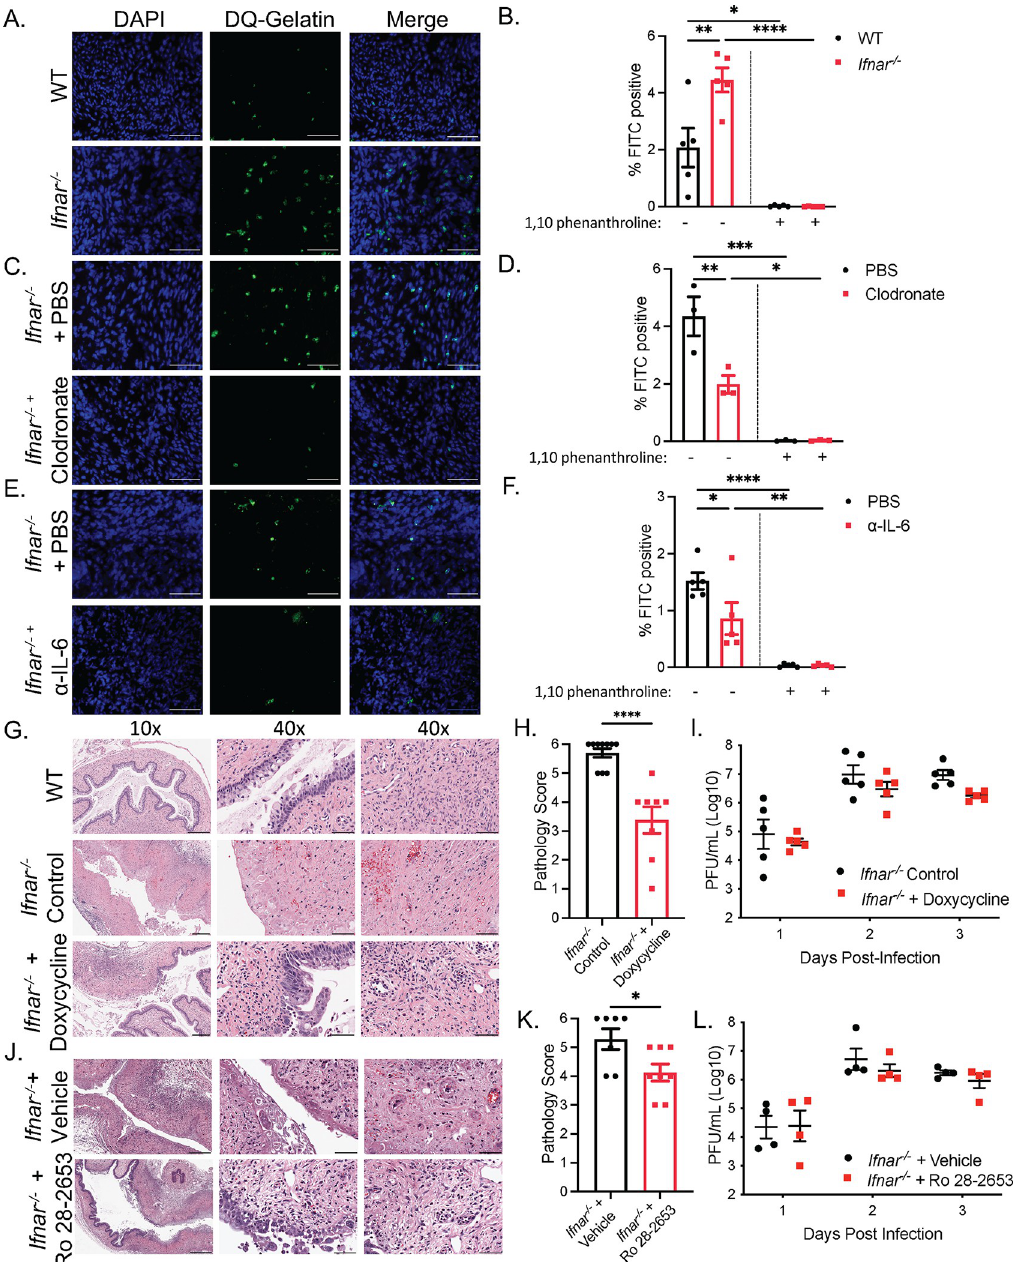
Fig 5. IL-6 regulates MMP proteolytic degradation of tissue following mucosal infection. (A) Representative images of in situ zymography of gelatinase activity by DQ gelatin (green) colocalizing with DAPI (blue) in the submucosa of HSV-2-infected WT and Ifnar -/- mice at 2.5 dpi. Scale bar represents 50 μ m. (B) % FITC positive cells in (A). 3 sections were analyzed and averaged per mouse. 3 separate images per section were quantified and averaged (n = 4). (C) Representative images of in situ zymography of HSV-2-infected Ifnar -/- mice administered PBS or clodronate liposomes at 2.5 dpi. (D) % FITC positive cells in (C) (n = 5). (E) Representative images of in situ zymography of Ifnar -/- mice administered PBS or α -IL-6 at 2.5 dpi. (F) % FITC positive cells in (E) (n = 3). (G and H) H&E staining (G) and pathology score (H) of vaginal cross-sections of HSV-2-infected WT and Ifnar -/- with or without doxycycline treatment at 3 dpi. Middle: vaginal epithelium, right: vaginal submucosa. 10x scale bar represents 200 μ m. 40x scale bar represents 50 μ m. (I) Viral titers in vaginal washes of HSV-2-infected WT and Ifnar -/- mice with or without doxycycline treatment from 1 to 3 dpi (n = 5). (J and K) H&E staining (J) and pathology score (K) or vaginal cross-sections of HSV-2-infected Ifnar -/- mice treated with vehicle or Ro 28–2653. (L) Viral titers of vaginal washes of HSV- 2-infected Ifnar -/- mice treated with vehicle or RO 28–2653 (n = 4). Data in (B), (D), (F), (H), (I), (K), (L) represented as mean ± SEM. � p < 0.05, �� p < 0.01, ��� p < 0.001, and ���� p < 0.0001 (B, D, F, I, L two-way ANOVA; H, K, two-tailed t-test). See also S5 Fig.